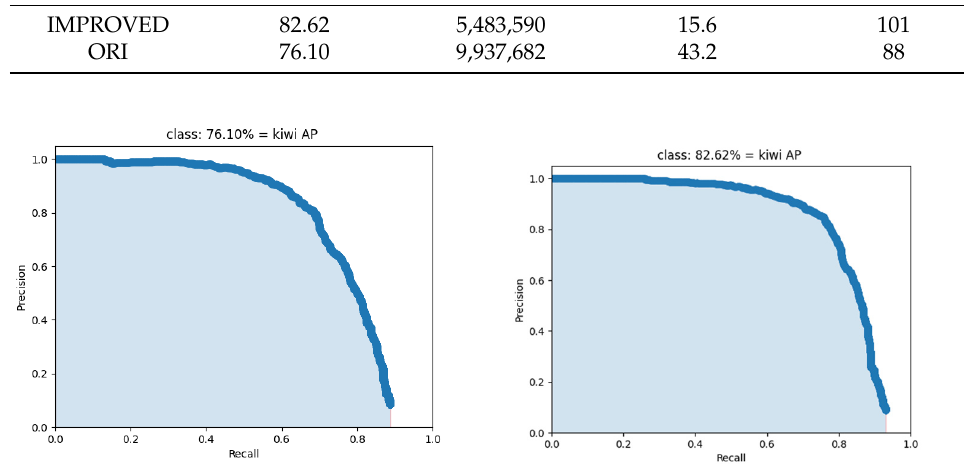
Figure 9. The YOLOX-S training curve.